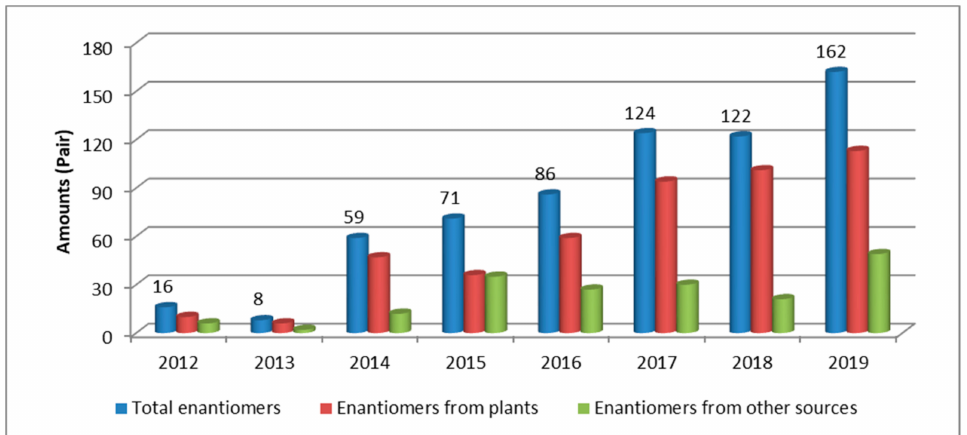
Figure 35. A comparison of enantiomeric pairs from plants and other sources.